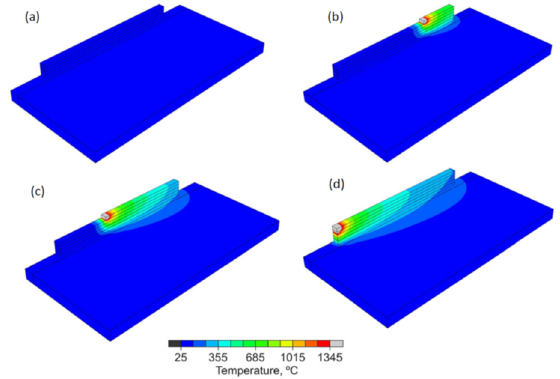
Figure 2. Temperature field at times ( a ) 0 s, ( b ) 15 s, ( c ) 30 s, and ( d ) 45 s.